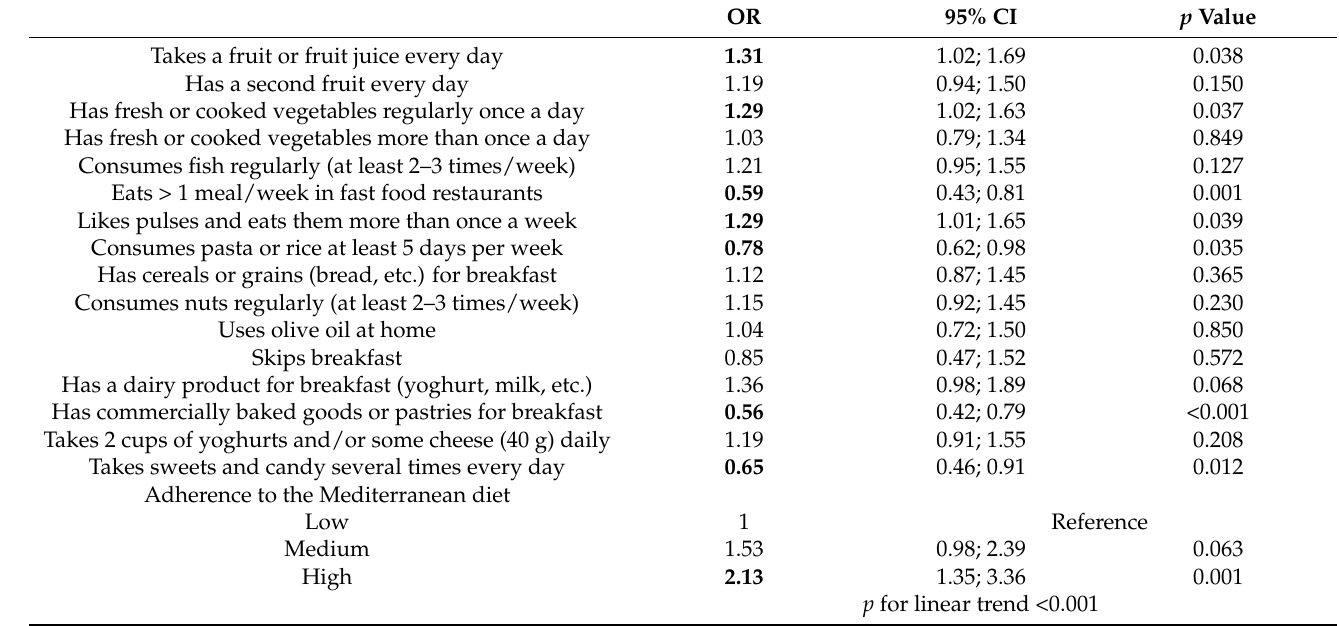
Table 2. Prospective association of baseline categories of the KIDMED index and each of its item with high quality of life at follow-up 1,2 . OR 95% CI p